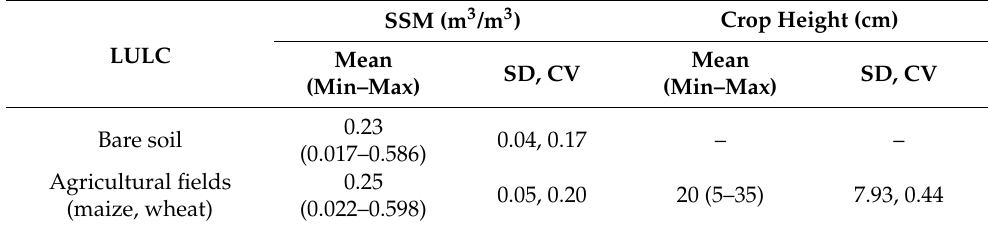
Table 3. Descriptive statistics of SSM using FieldScout TDR–300 over bare soil ( n = 23) and vegetated agricultural fields ( n = 31) during 15–18 February 2021. Similarly, crop height information has been shown.